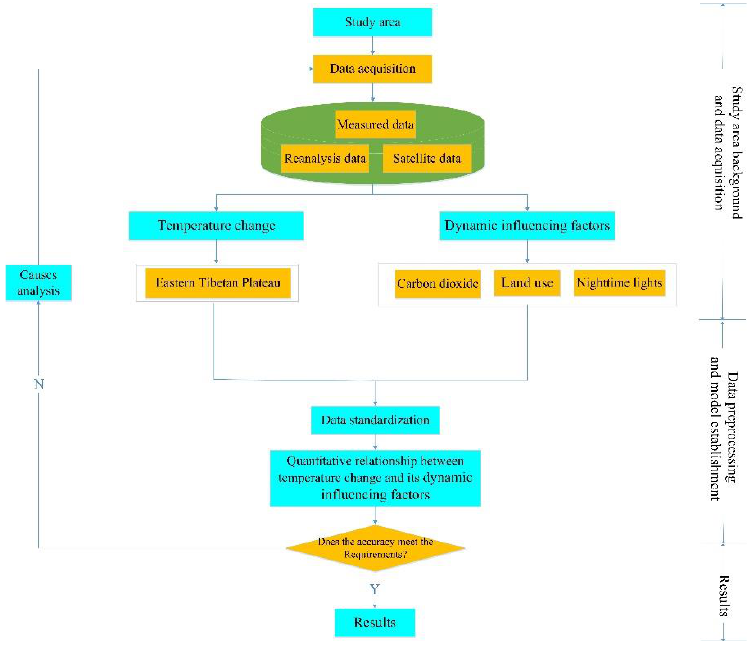
Figure 4. Technical flowchart for establishing the model between the standardized temperature change and dynamic influencing factors.